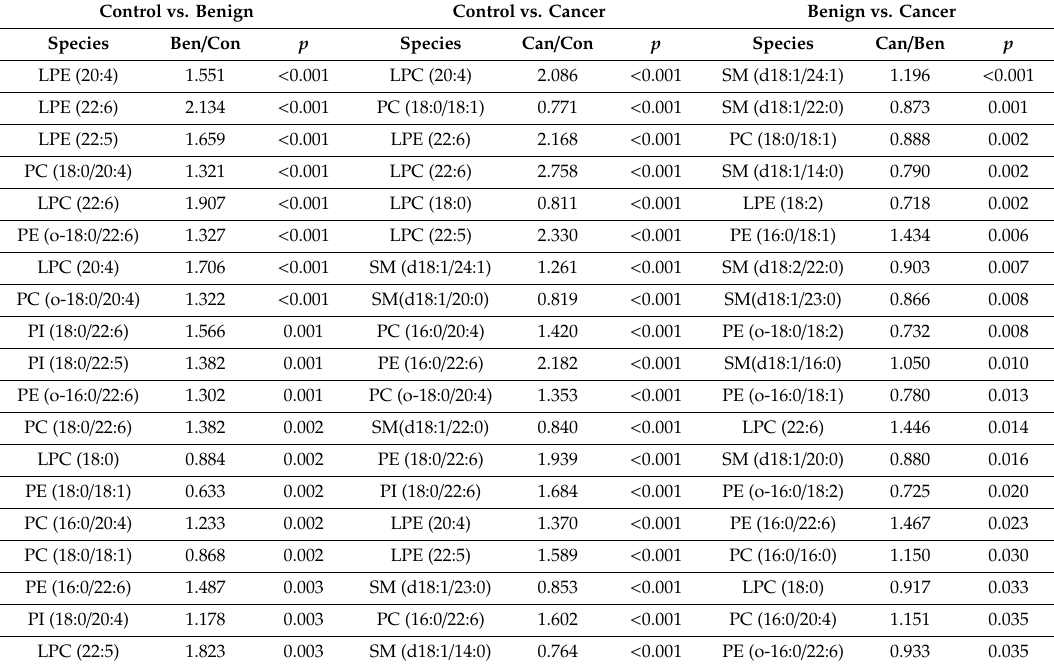
Table 2. The content of phospholipids, lysophospholipids, and sphingomyelin by normalizing the intensities of individual peak areas to the total content of phospholipids. Control vs. Benign Control vs. Cancer Benign vs. Cancer